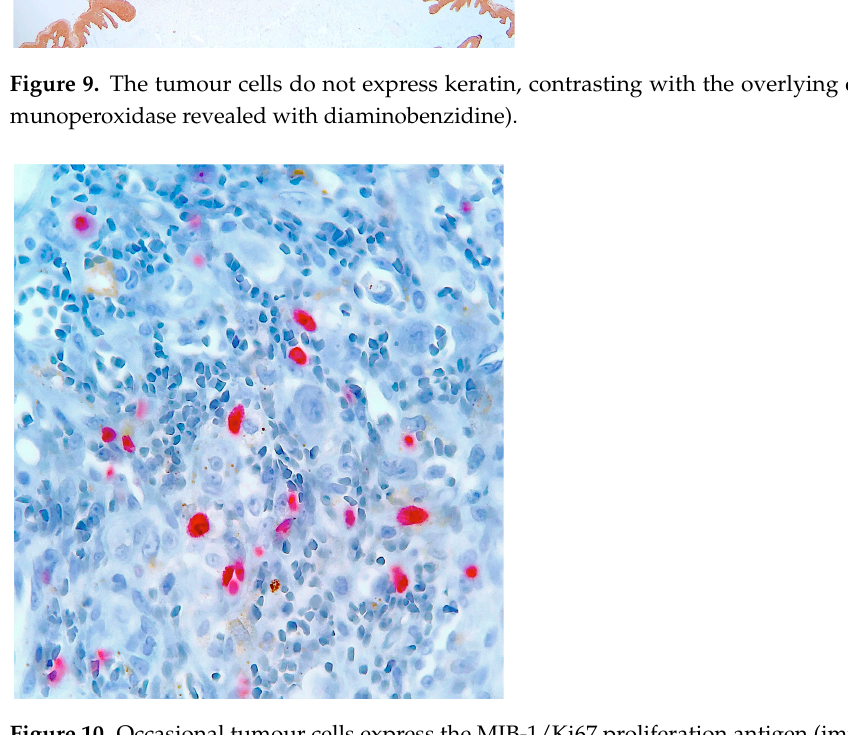
phosphatase revealed with fast-red).